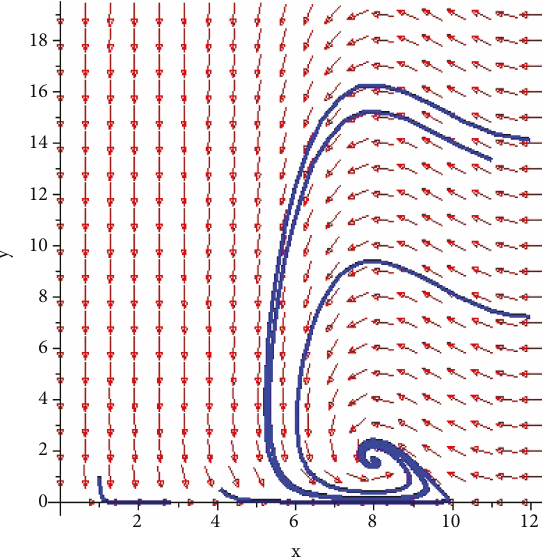
Figure 2: The vector diagram of system (8) where r = 4 , a = 0 4 , b = 0 5 , m 1 = 8 , and m 2 = 12